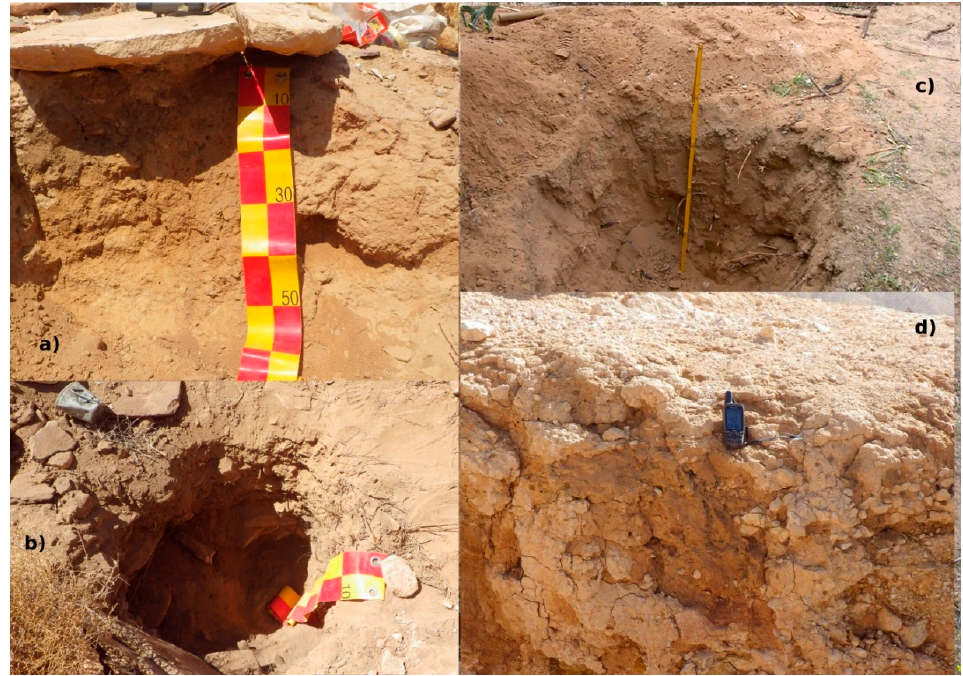
Figure 5. Studied profiles in the Petra region. ( a ) Soil cover on the debris in the northern courtyard of the monastery of Jabal Haroun, ( b ) Umm Saysaban (GPS and backpack give scale), and ( c ) the triclinium of Jabal Farasha. The tape measure is in cm. For a detailed description of the profiles, see Appendix A.